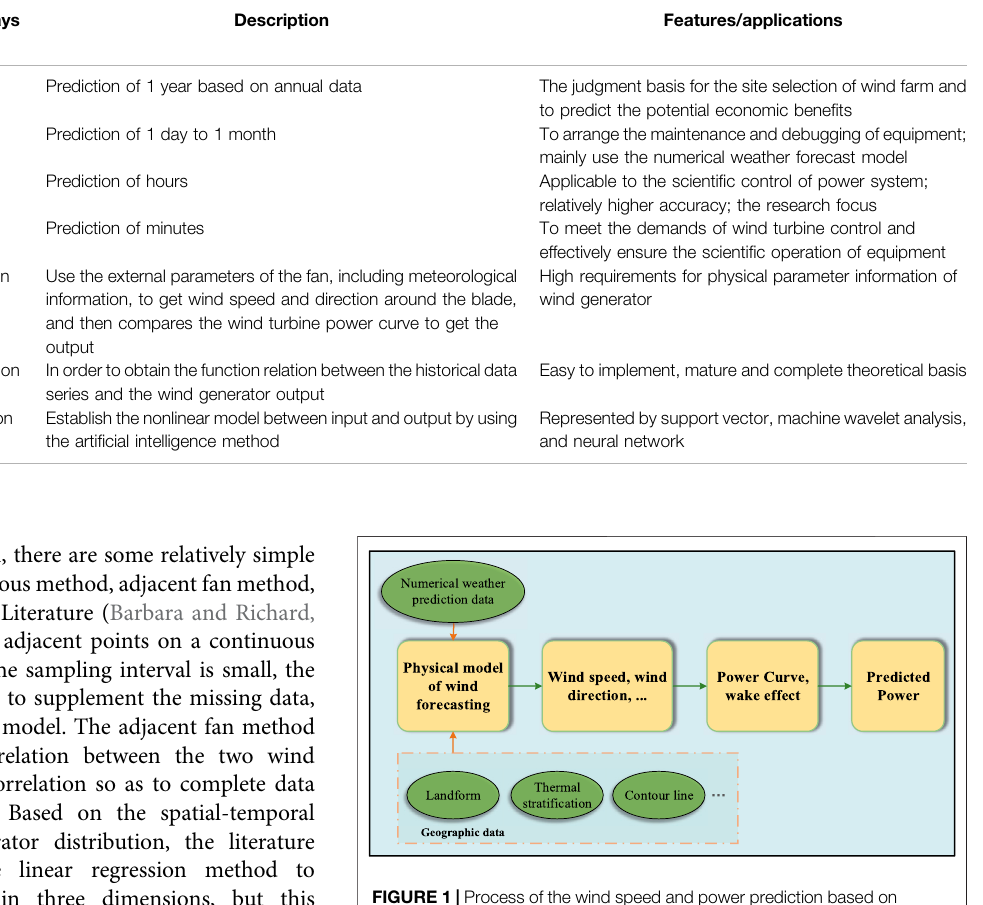
TABLE 1 | Prediction approaches on time/model horizon.